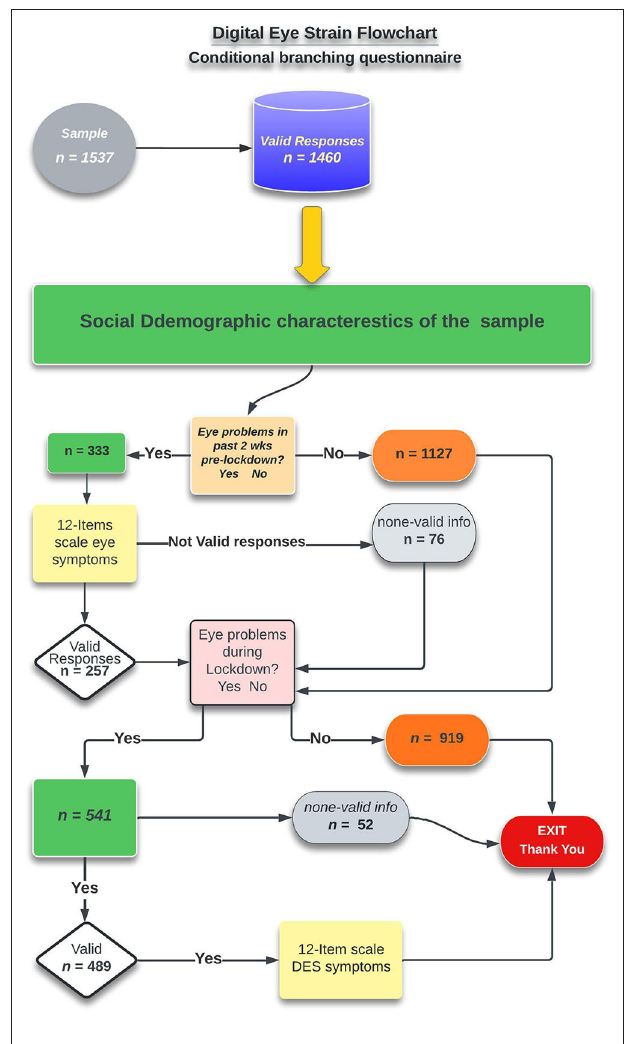
FIGURE 1 | Flowchart depicting the organization of the survey questions and their conditional branching.